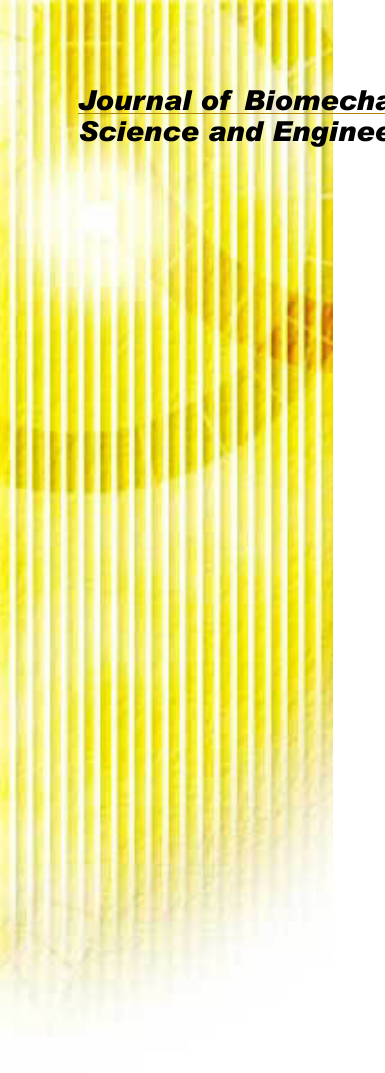
The range of motion (ROM) was defined as the unilateral angular deformation of each segment during bending of the spinal column from the neutral position to 8° of flexion and to 8° of extension. In the intact spine, the mean ROM (±standard deviation) during flexion was 1.3 ± 0.4°, 1.8 ± 0.4°, and 4.9 ± 0.6° at L3/4, L4/5, and L5/6, respectively, during flexion, and the mean ROM during extension was 2.0 ± 1.0°, 3.7 ± 1.1°, and 2.3 ± 1.0°, respectively. In MF, the mean ROM in the flexed position was 1.3 ± 0.4°, 2.0 ± 0.5°, and 4.7 ± 0.7° at L3/4, L4/5, and L5/6, respectively, and the respective mean ROM in the extended position was 2.0 ± 1.0°, 4.1±1.1°, and 1.8±1.0°. No significant differences